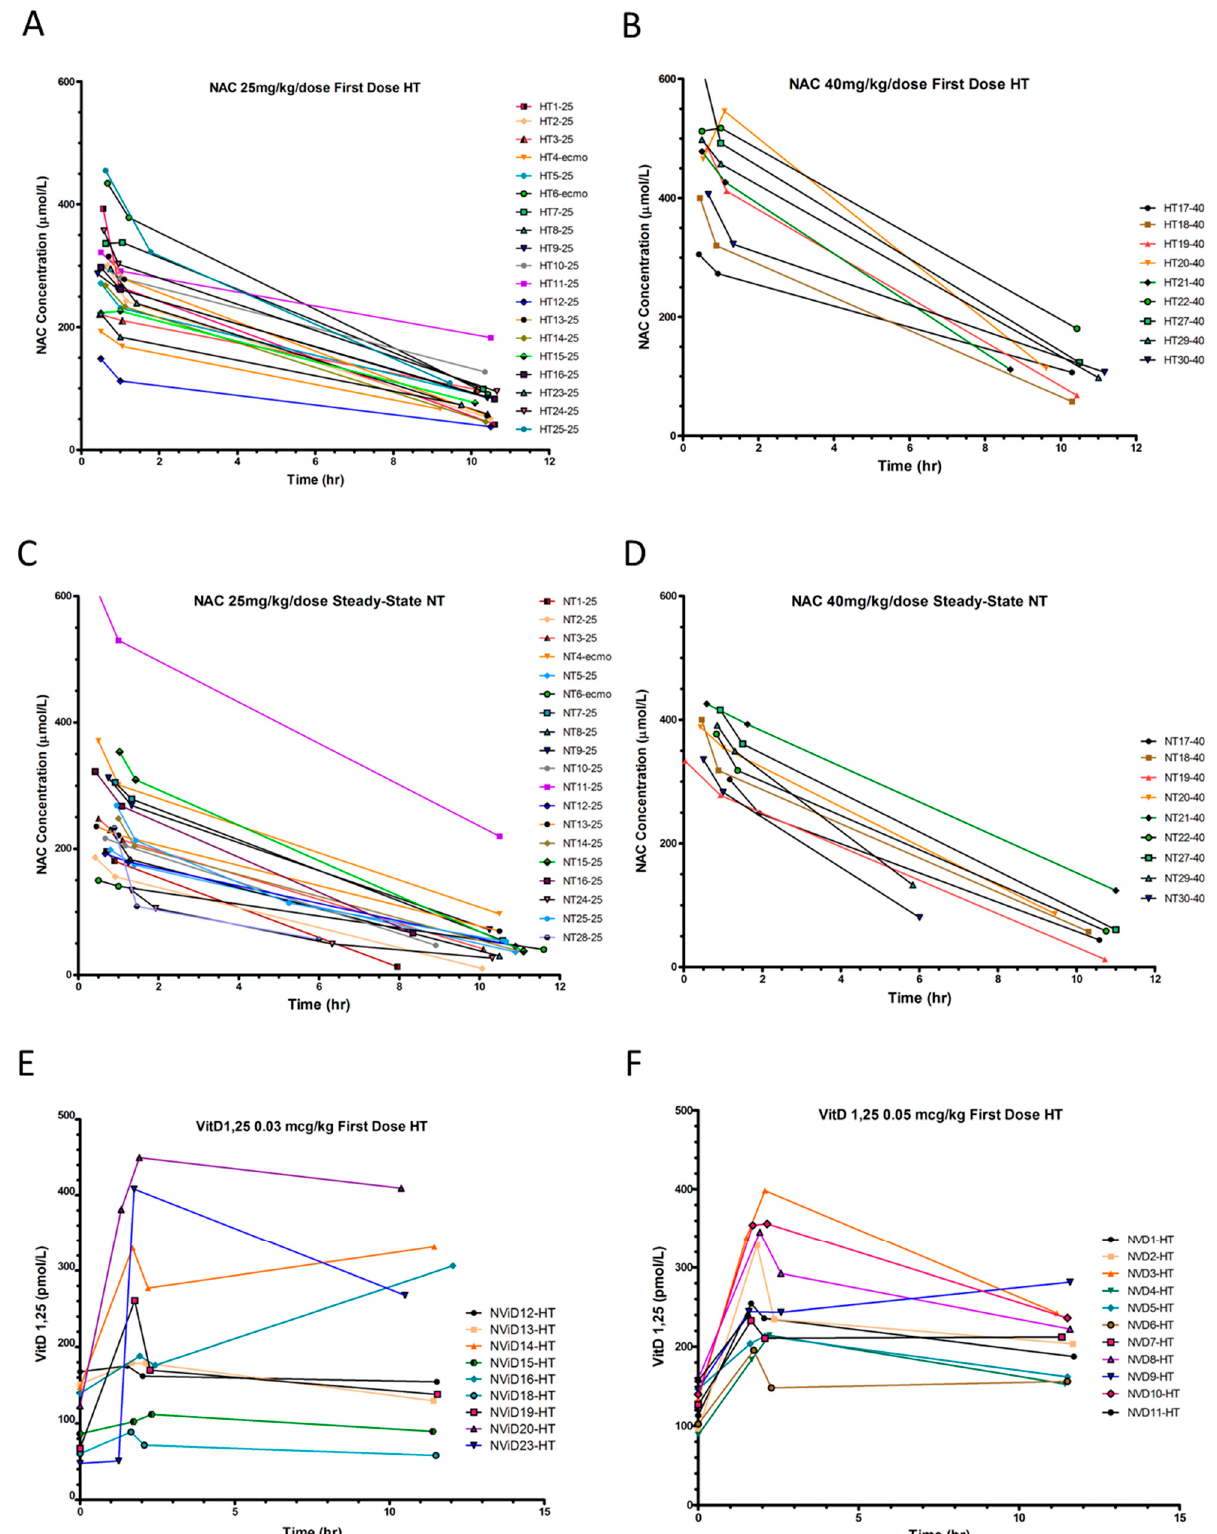
Figure 2. Plasma NAC and serum 1,25(OH) 2 D concentrations and pharmacokinetics. ( A , B ) Plasma NAC concentrations during hypothermia (HT) and ( C , D ) normothermia (NT), with NAC ( A , C ) 25 mg/kg/dose and ( B , D ) 40 mg/kg/dose. ( E , F ) 1,25(OH) 2 D serum concentrations during HT with calcitriol ( E ) 0.03 mcg/kg/dose, ( F ) 0.05 mcg/kg/dose.